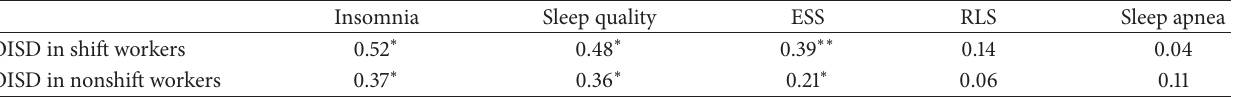
Table 3: Correlations between different types of sleep disorders with OISD in two groups of shift workers and nonshift workers. Insomnia Sleep quality ESS